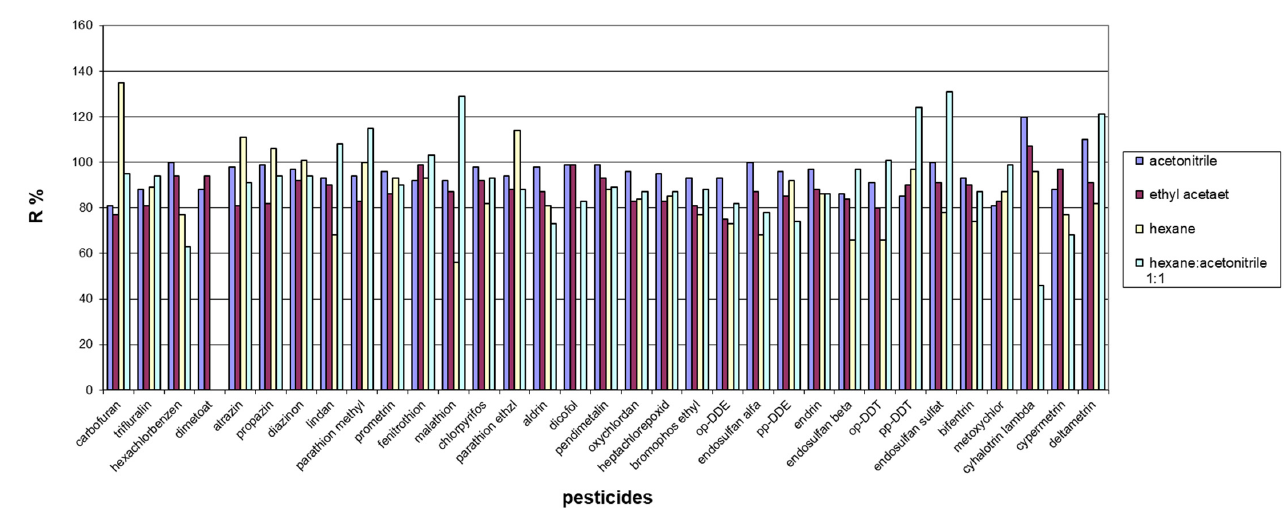
Figure 1. Selection of extraction solvent. The dependence of the extraction recovery of individual pesticides on the selection of the solvent.